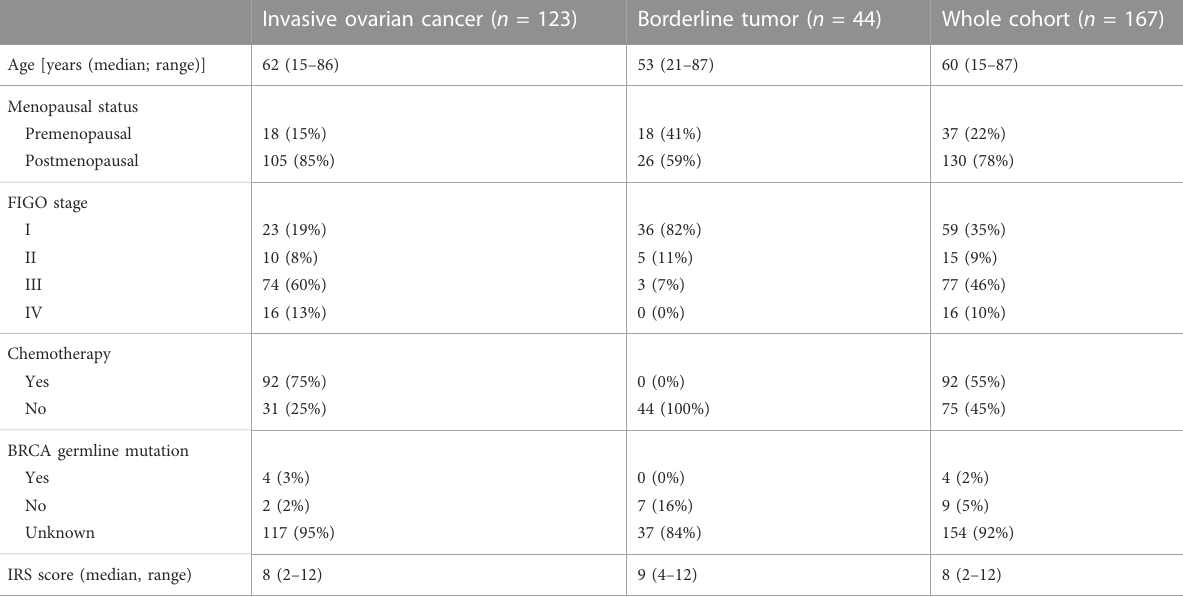
TABLE 1 Patients ’ characteristics (IRS = immunoreactive score) ( n = 167). Invasive ovarian cancer ( n =